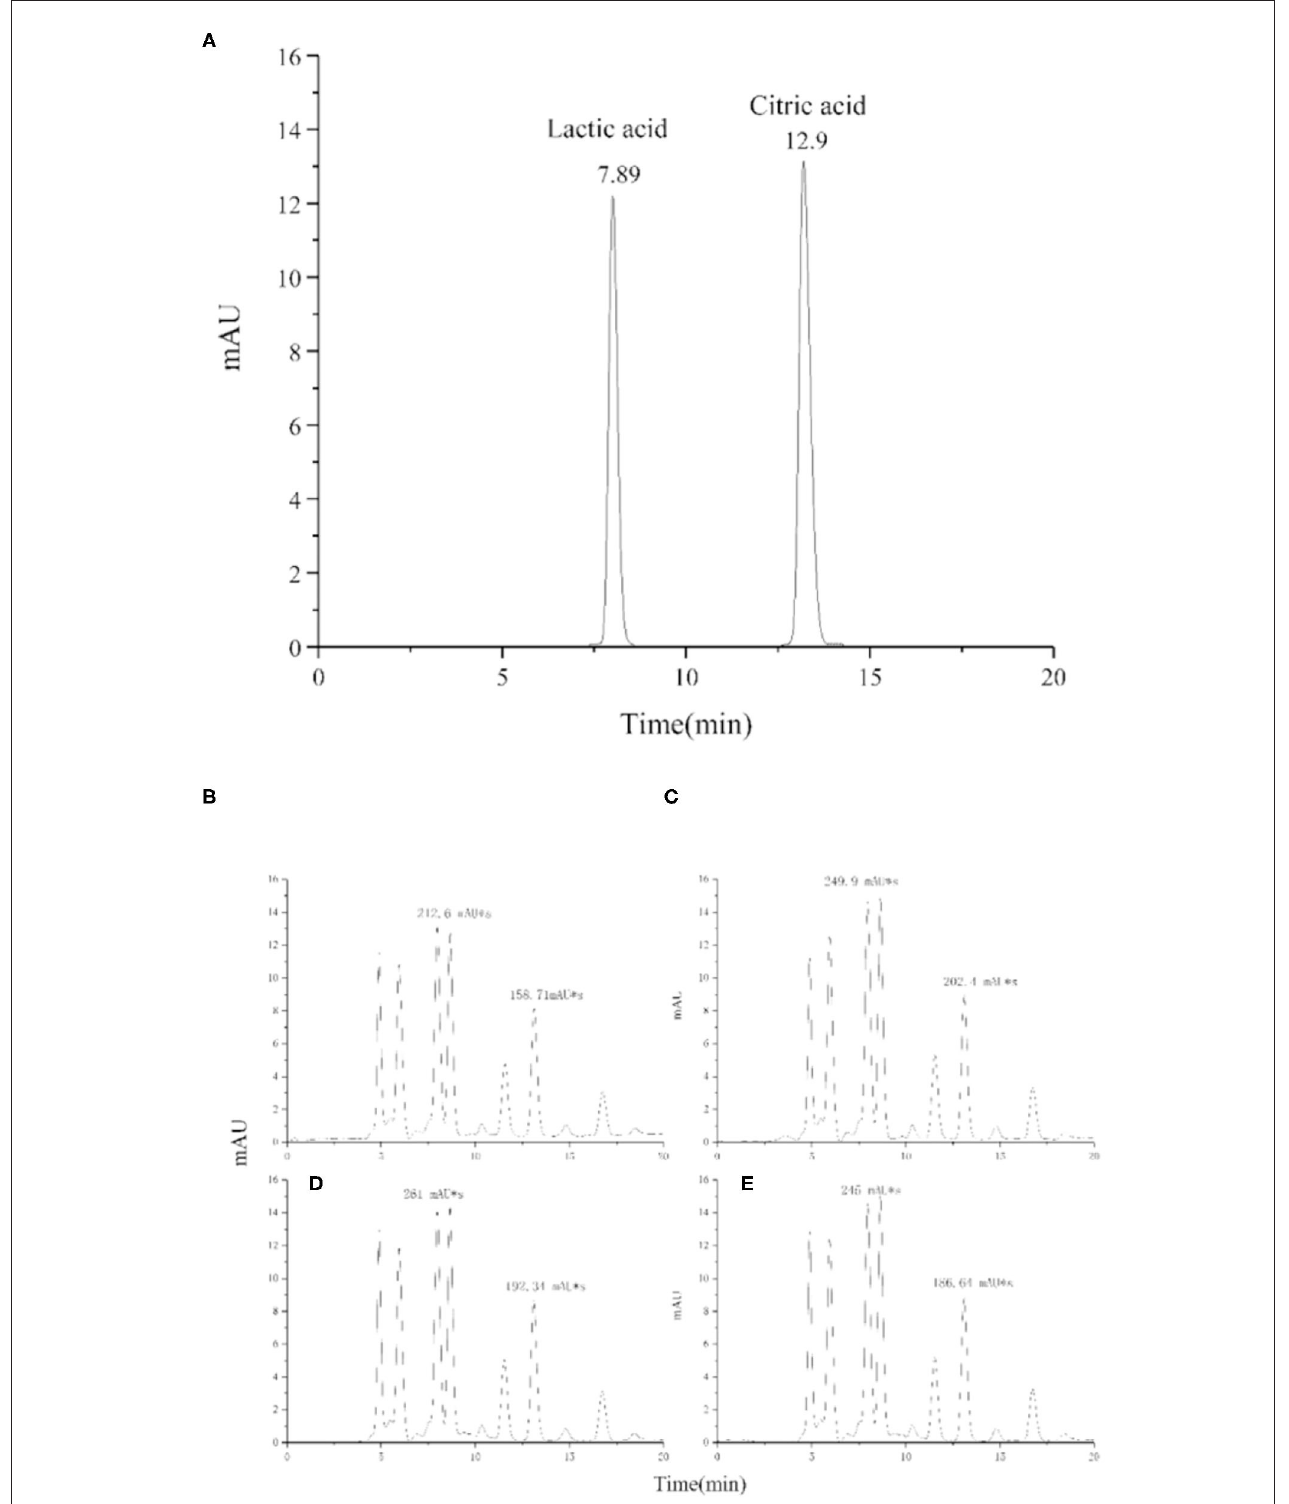
FIGURE 11 | HPLC chromatogram of lactic acid and citric acid in standard sample (A) and yogurt samples, 0 mg/mL procyanidin (B) , 0.1 mg/mL procyanidin (C) , 0.25 mg/mL procyanidin (D), and 0.5 mg/mL procyanidin (E) .